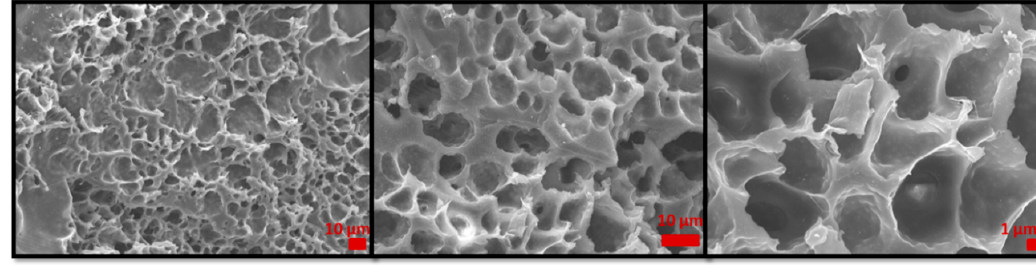
Figure 4. FE-SEM images of the microporous structure of the freeze-dried hydrogels.